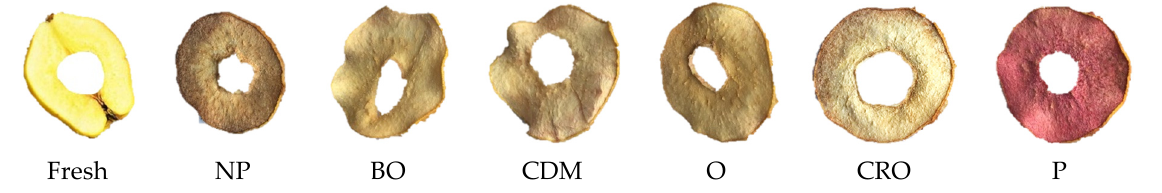
Figure 6. Fresh, non-pre-treated (NP) and dried in 1 min dipping time with different fruit juices. (tangerine ( Citrus deliciosa Mediterranean) (CDM); orange (O); bitter orange (BO); tangerine ( Citrus reticulate Owari) (CRO); pomegranate (P)).